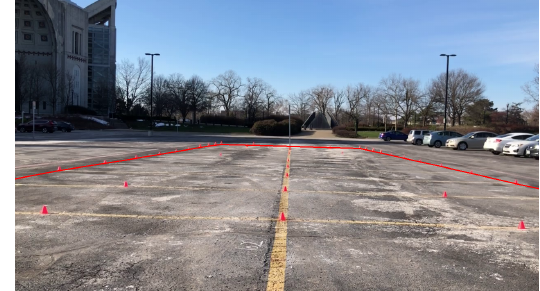
Figure 7. Camera view from monocular camera mounted on the vehicle. Red polyline is the margin of ROI. HE-Net will be activated only objects whose bottom points are within ROI. Cones on the ground are markers for homography